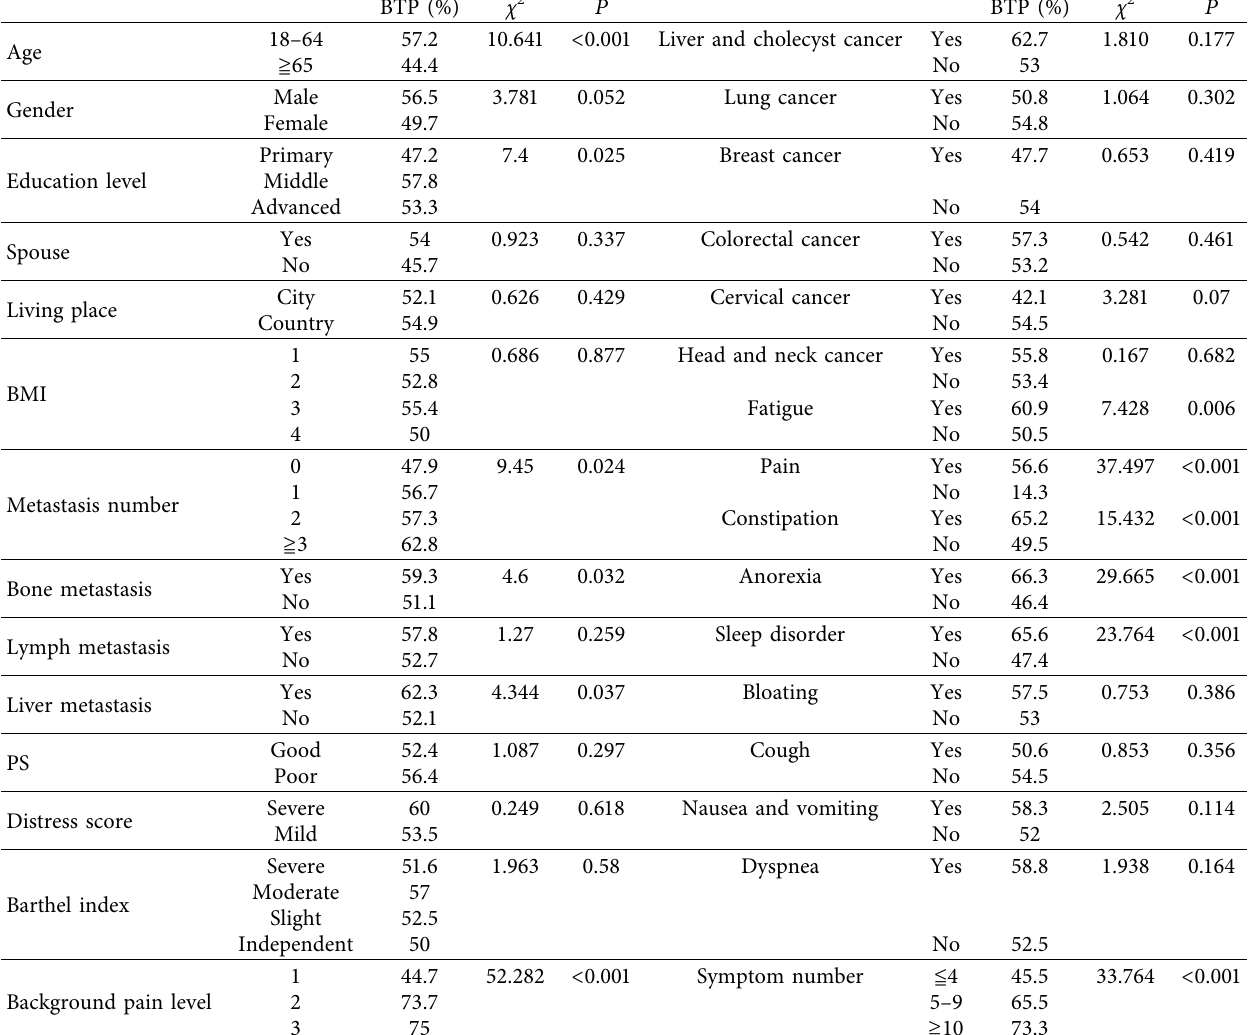
Table 3: Univariate analysis of BTP incidence among demographic data.